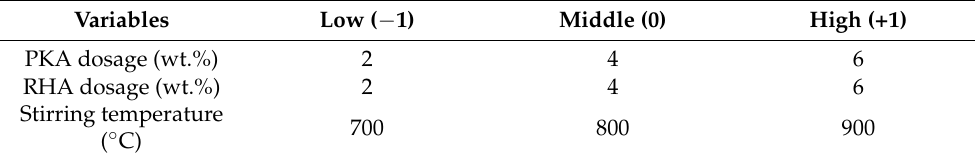
Table 1. Levels of the design.